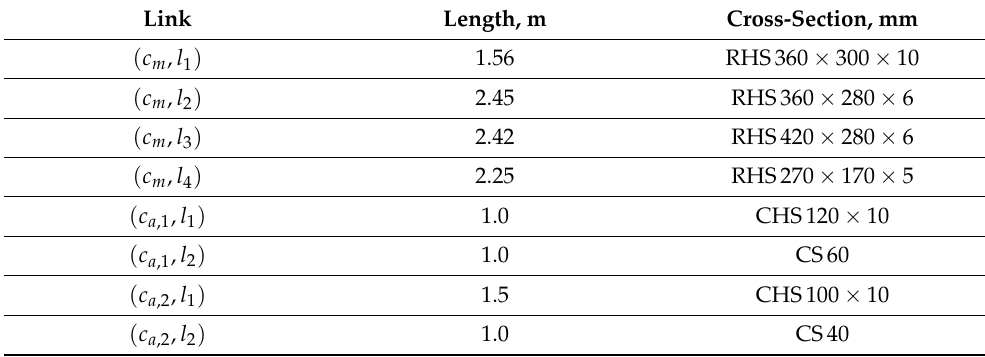
Table 1. Parameters of the links.